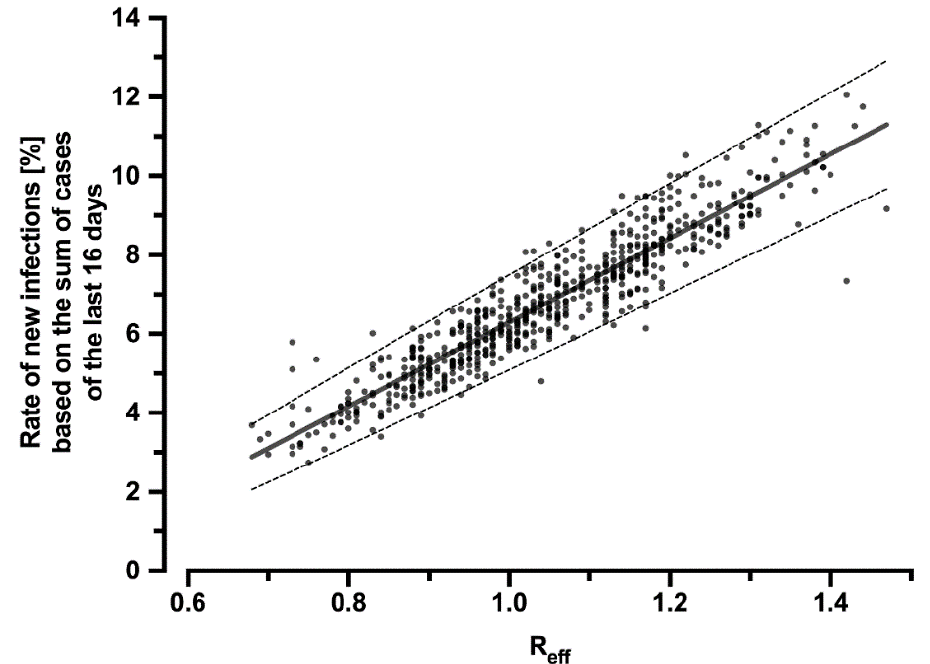
Figure 2. Correlation of the effective reproduction number R eff with the percentage rate of new infections related to the sum of cases over the last 16 days. The regression line can be described by the equation y = 0.1064x − 0.04353 (R 2 = 0.87) and is symbolized by the solid line. The dashed lines indicate the 95% CI (slope: 0.1034–0.1095; y-intercept: − 0.04669– − 0.04038). The dots represent the individual values for each day during the period under consideration.